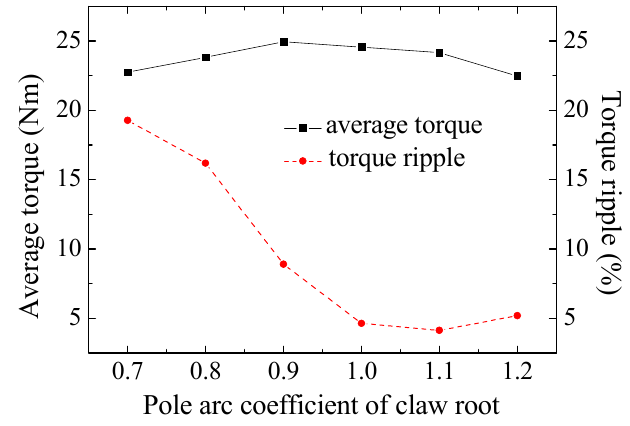
Figure 20. Variation of average torque and torque ripple with pole arc coefficient of the claw root.